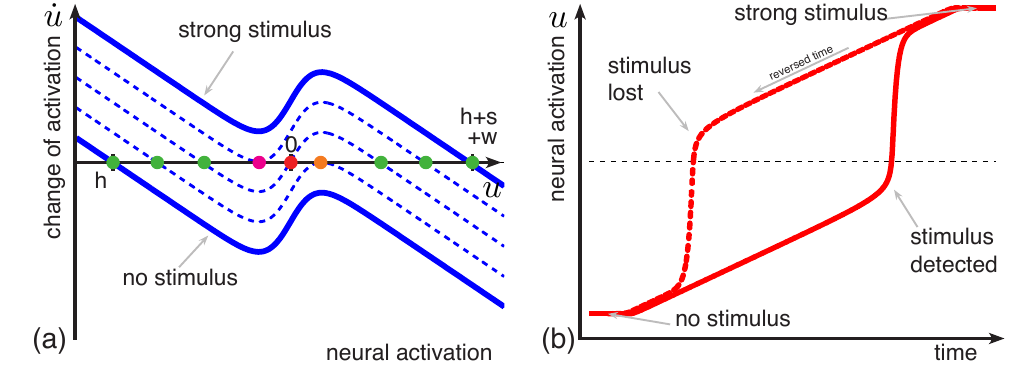
Figure 9: Dynamics of a single self-exciting neuron with systematically increasing stimulus strengths. The phase plot (a) is given for the limit cases of no stimulus and a strong stimulus (solid lines) and three intermediate values (dashed). The attractors and repellors are in- dicated by the green and red dots for each case, the magenta and orange dots are a pair of attracting/repelling fixed points that are on the verge of appearing (or disappearing) in a bifurcation. Panel (b) shows two example trajectories for increasing (solid) and decreasing (dashed) stimulus, the latter plotted reversed in